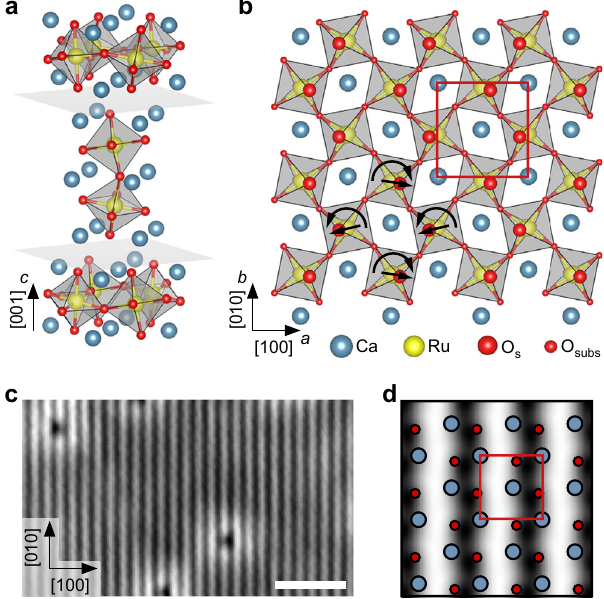
Fig. 1 The cleaved calcium ruthenate surface. a Unit cell of the n = 2 member of the Ca n+1 Ru n O 2n+1 Ruddlesden Popper series. The crystal cleaves easily between neighboring CaO layers (marked by gray planes ). b Top view of the CaO-terminated Ca 3 Ru 2 O 7 (001) surface. The RuO 6 octahedra are alternately tilted with respect to the c axis (most pronounced in the ac plane), and rotated in the ab plane as indicated by the straight and curved arrows , respectively. The red box marks the orthorhombic unit cell ( a = 5.365 Å, b = 5.562 Å). c STM image of the cleaved surface. The dark ( bright ) lines along the [010] direction correspond to areas where the apical oxygen atoms of the RuO 6 octahedra are tilted toward (away from) each other (see panel d ). The point defects are attributed to spurious impurities (see SI). The scale bar corresponds to 3 nm. STM parameters: T sample = 78 K, V sample = +0.8 V, I tunnel = 0.1 nA; image rotated and cropped; fast scan direction is 68° clockwise from horizontal. d Tersoff-Hamann simulation of the cleaved